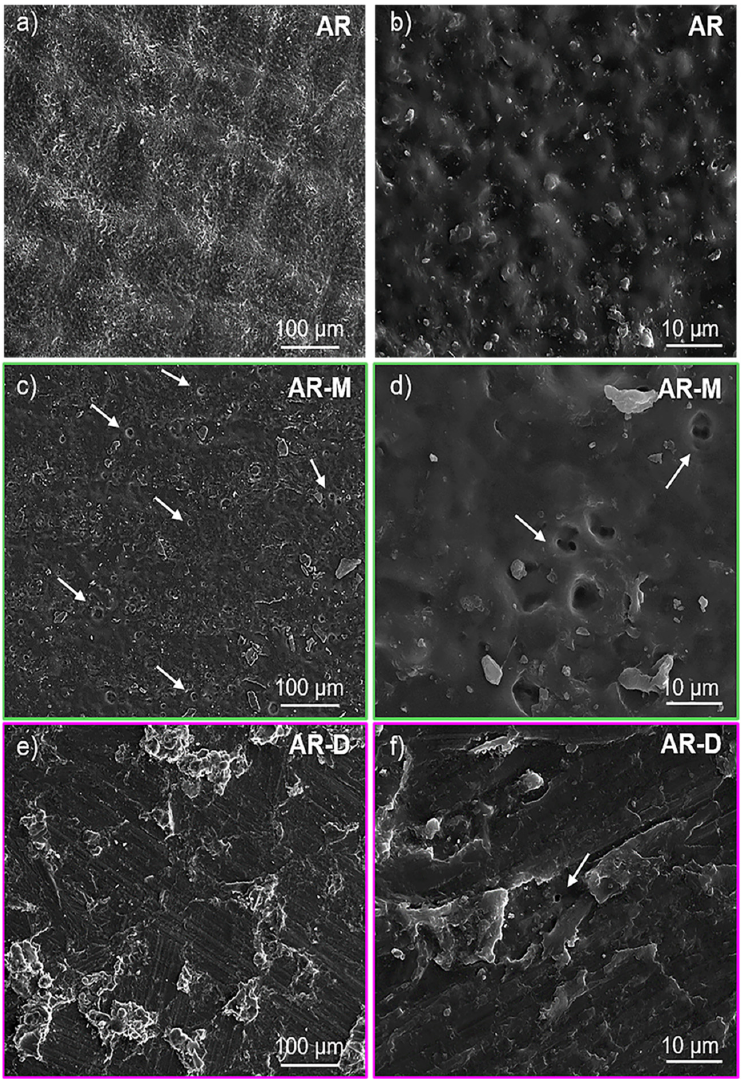
Figure 3. SEM images of samples AR ( a , b ), AR-M ( c , d ), and AR-D ( e , f ) obtained at lower (left) and higher (right)